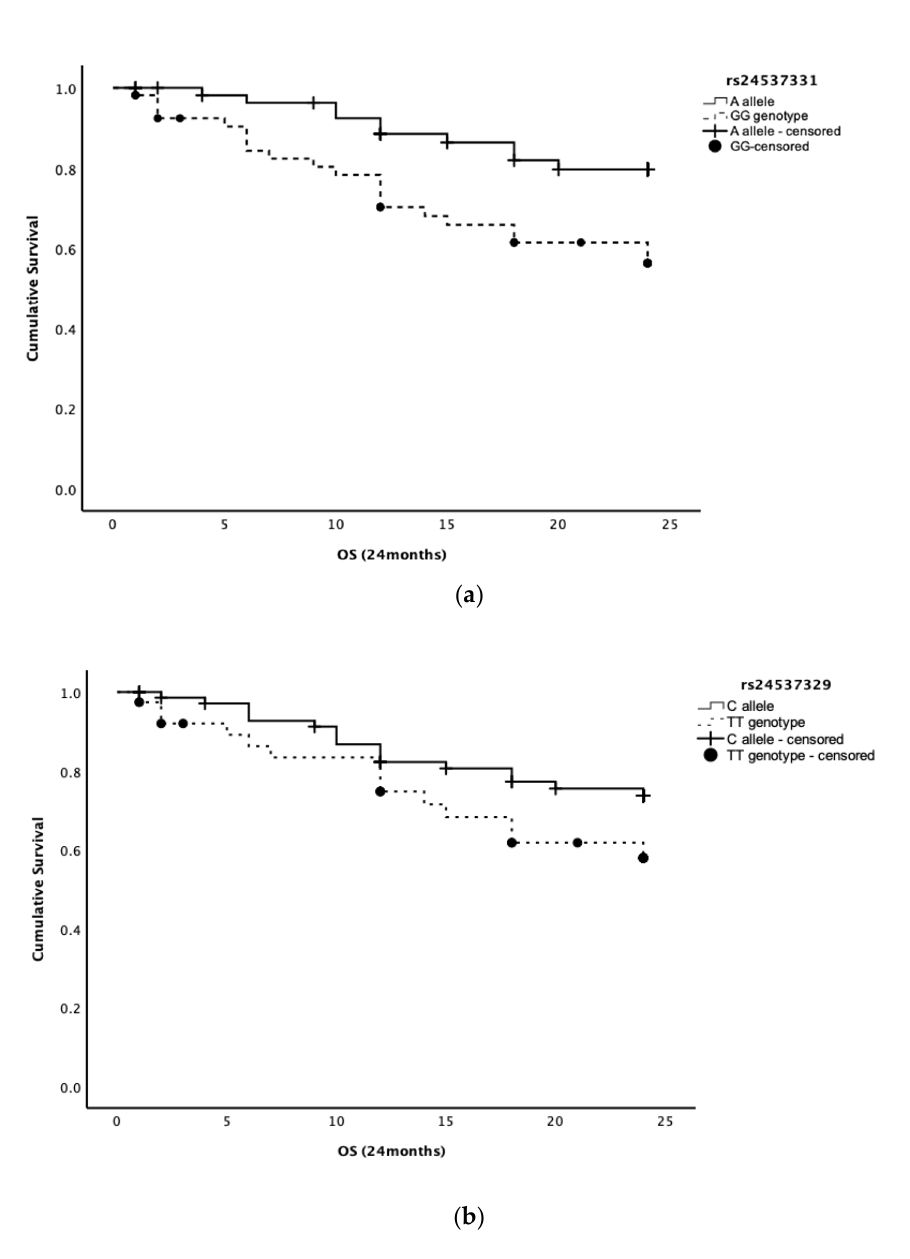
Figure 1. ( a ) Kaplan–Meier plots of the estimate of disease-specific overall survival for variant allele carriers (A allele; n = 60) and wild-type genotype (GG genotype; n = 55) for SNP rs24537331 in HER2 canine gene ( p = 0.009) in a total population of 115 female dogs with at least one malignant mammary tumor. Censoring is indicated by the + symbol. ( b ) Kaplan–Meier plots of the estimate of disease-specific overall survival for variant allele carriers (C allele; n = 76) and wild-type genotype (TT genotype; n = 39) for SNP rs24537329 in HER2 canine gene ( p = 0.105) in a total population of 115 female dogs with at least one malignant mammary tumor. Censoring is indicated by the + symbol.